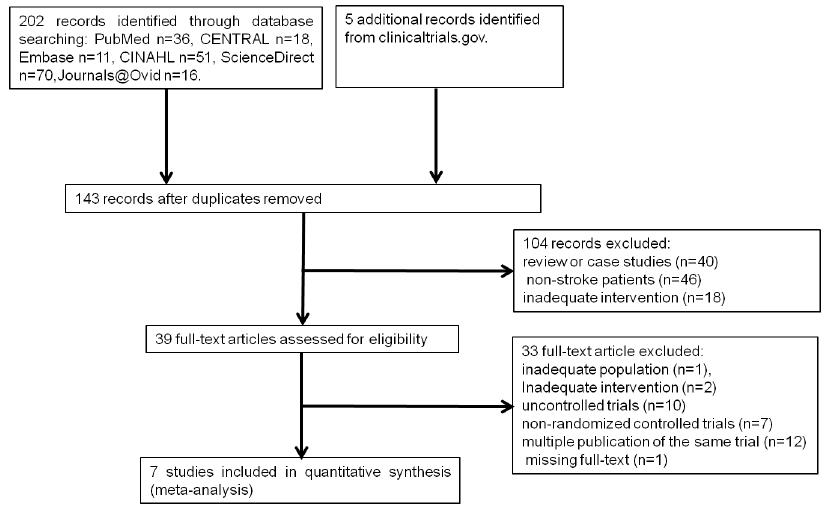
Figure 1. Flowchart for the inclusion of studies.